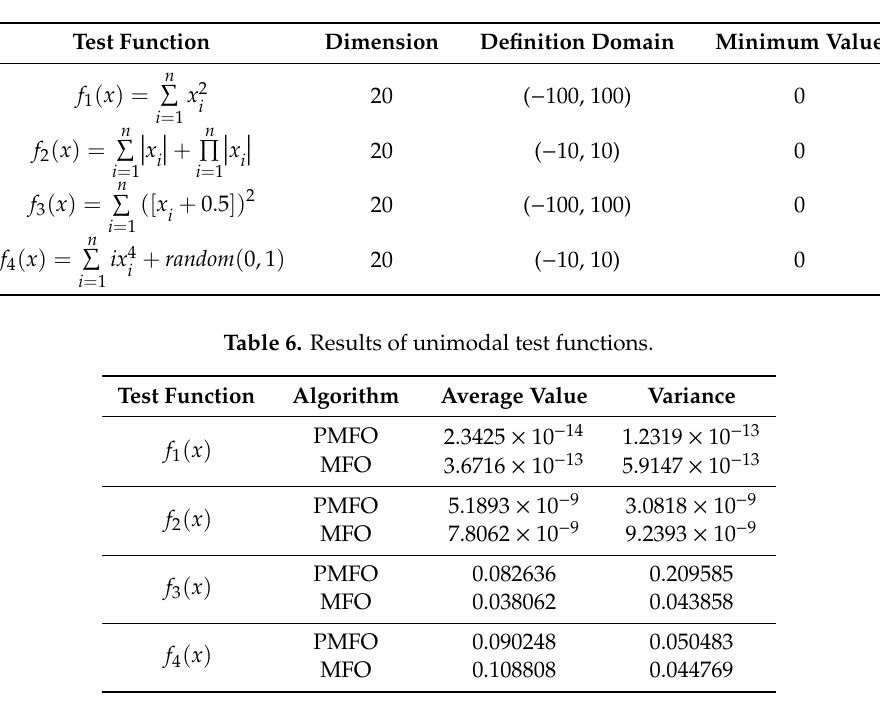
Table 5. Unimodal test functions.